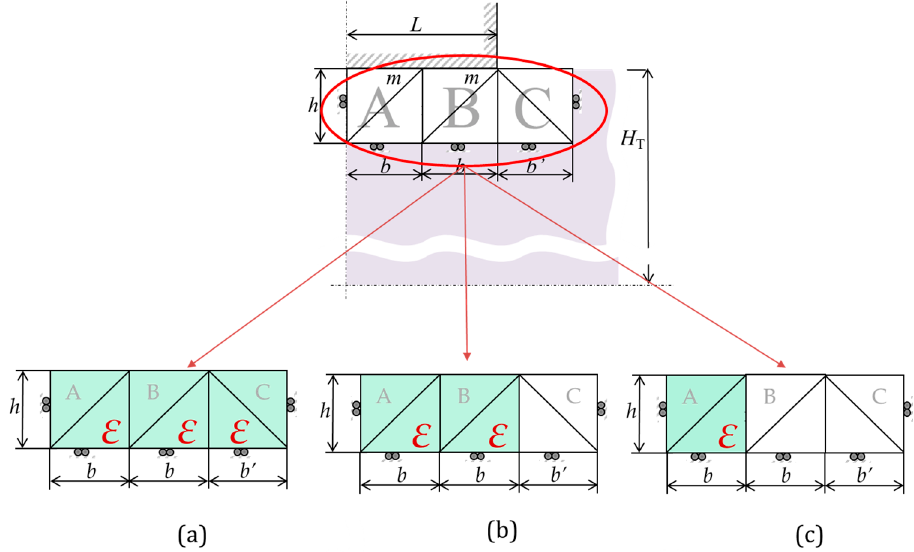
Figure 1. Optimal MUBT model (three modules with two triangular rigid zones each) and hardening effect ( ε ) distribution for each Hardening Model (HM): ( a ) HM1; ( b ) HM2; and ( c ) HM3.